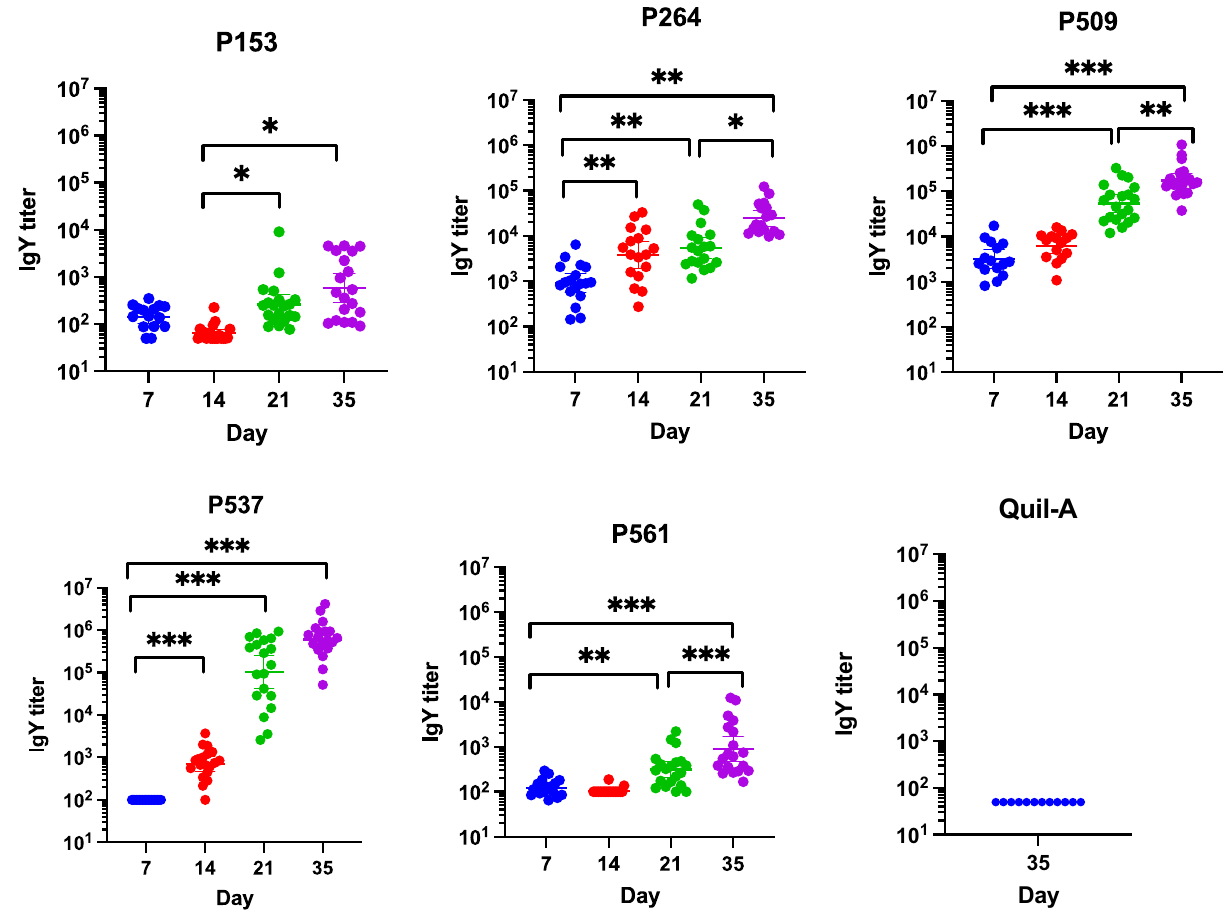
Figure 4. Evaluation of the serum IgY antibody titer on days 7, 14, 21, and 35 against the indicated recombinant protein by ELISA. Chickens were immunized intramuscularly with purified recombinant protein mixed with the adjuvant Quil-A. Birds from the negative control group were immunized with adjuvant alone. The error bars represent standard error on means of two repeats. *P ≤ 0.05; **P ≤ 0.01; ***P ≤ 0.001,